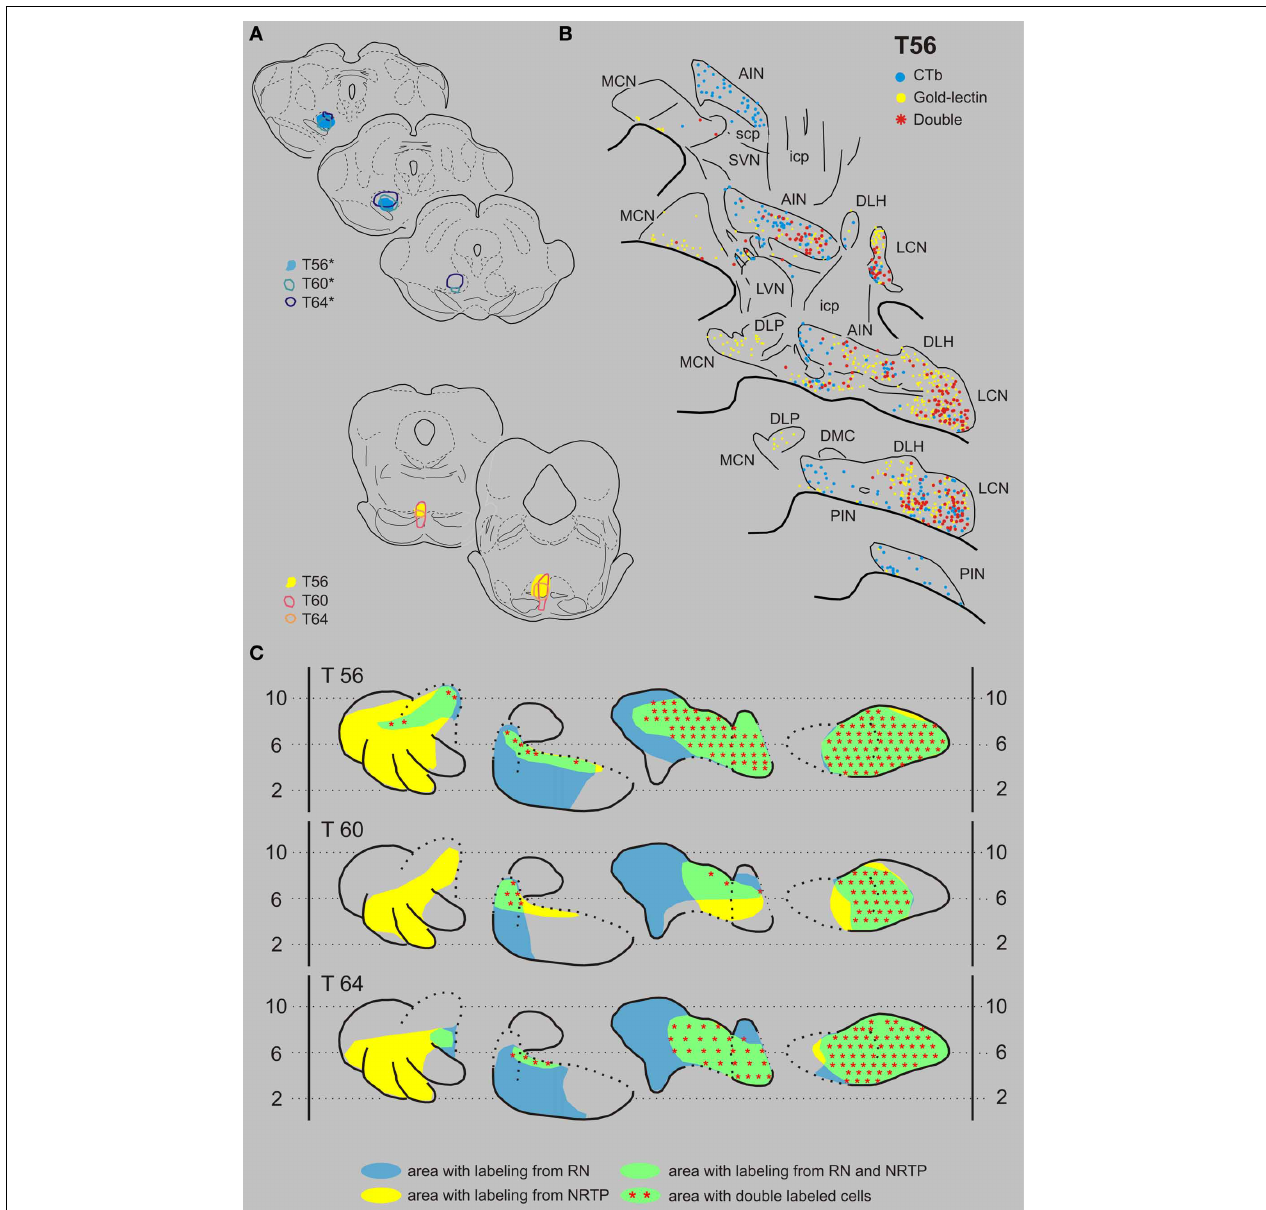
FIGURE 6 | Diagrams depicting results of the combination NRTP and the RN. (A) Injection sites of all three analyzed cases. Upper left hand panels show the injection sites within transverse diagrams of the midbrain. Bottom panels show the related injections sites in the NRTP. CTb injections (case number indicated with ∗ ) were made in the RN of all three cases. (B) Plots of 5 equidistant (320 micron) sections showing labeled neurons within the